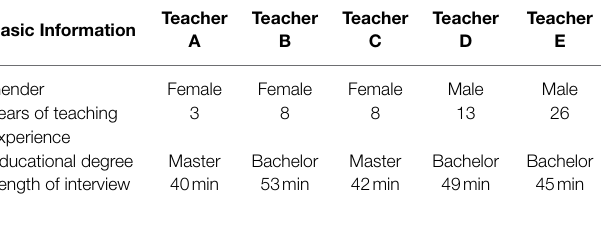
TABLE 2 | Basic information from the CD-RISC-EFL Teacher Survey.